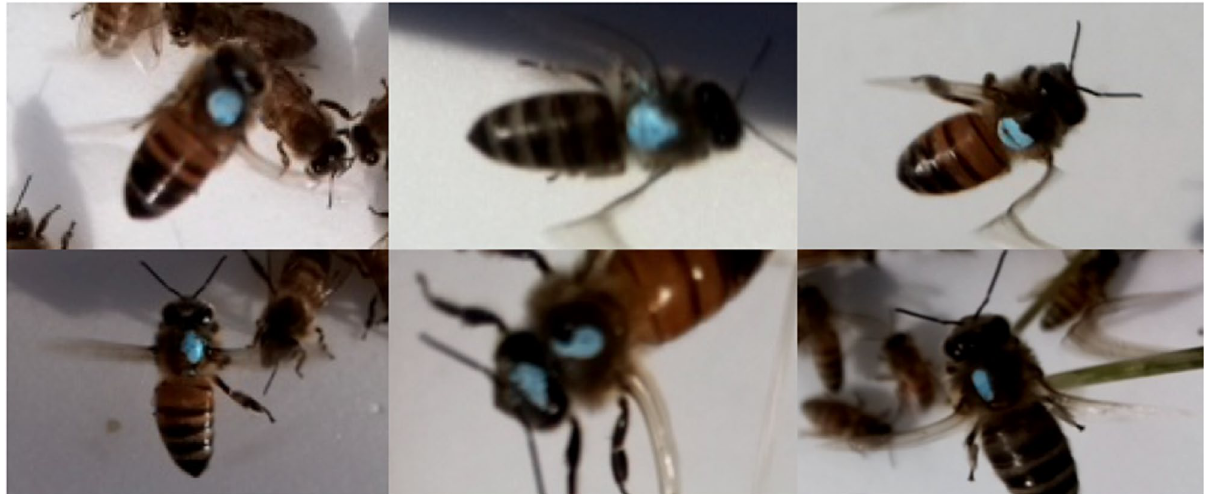
Figure 5. Examples of how unique paint markings can be used to tell individuals apart. Paint markings, in combination with the timing of photos, were used to determine unique